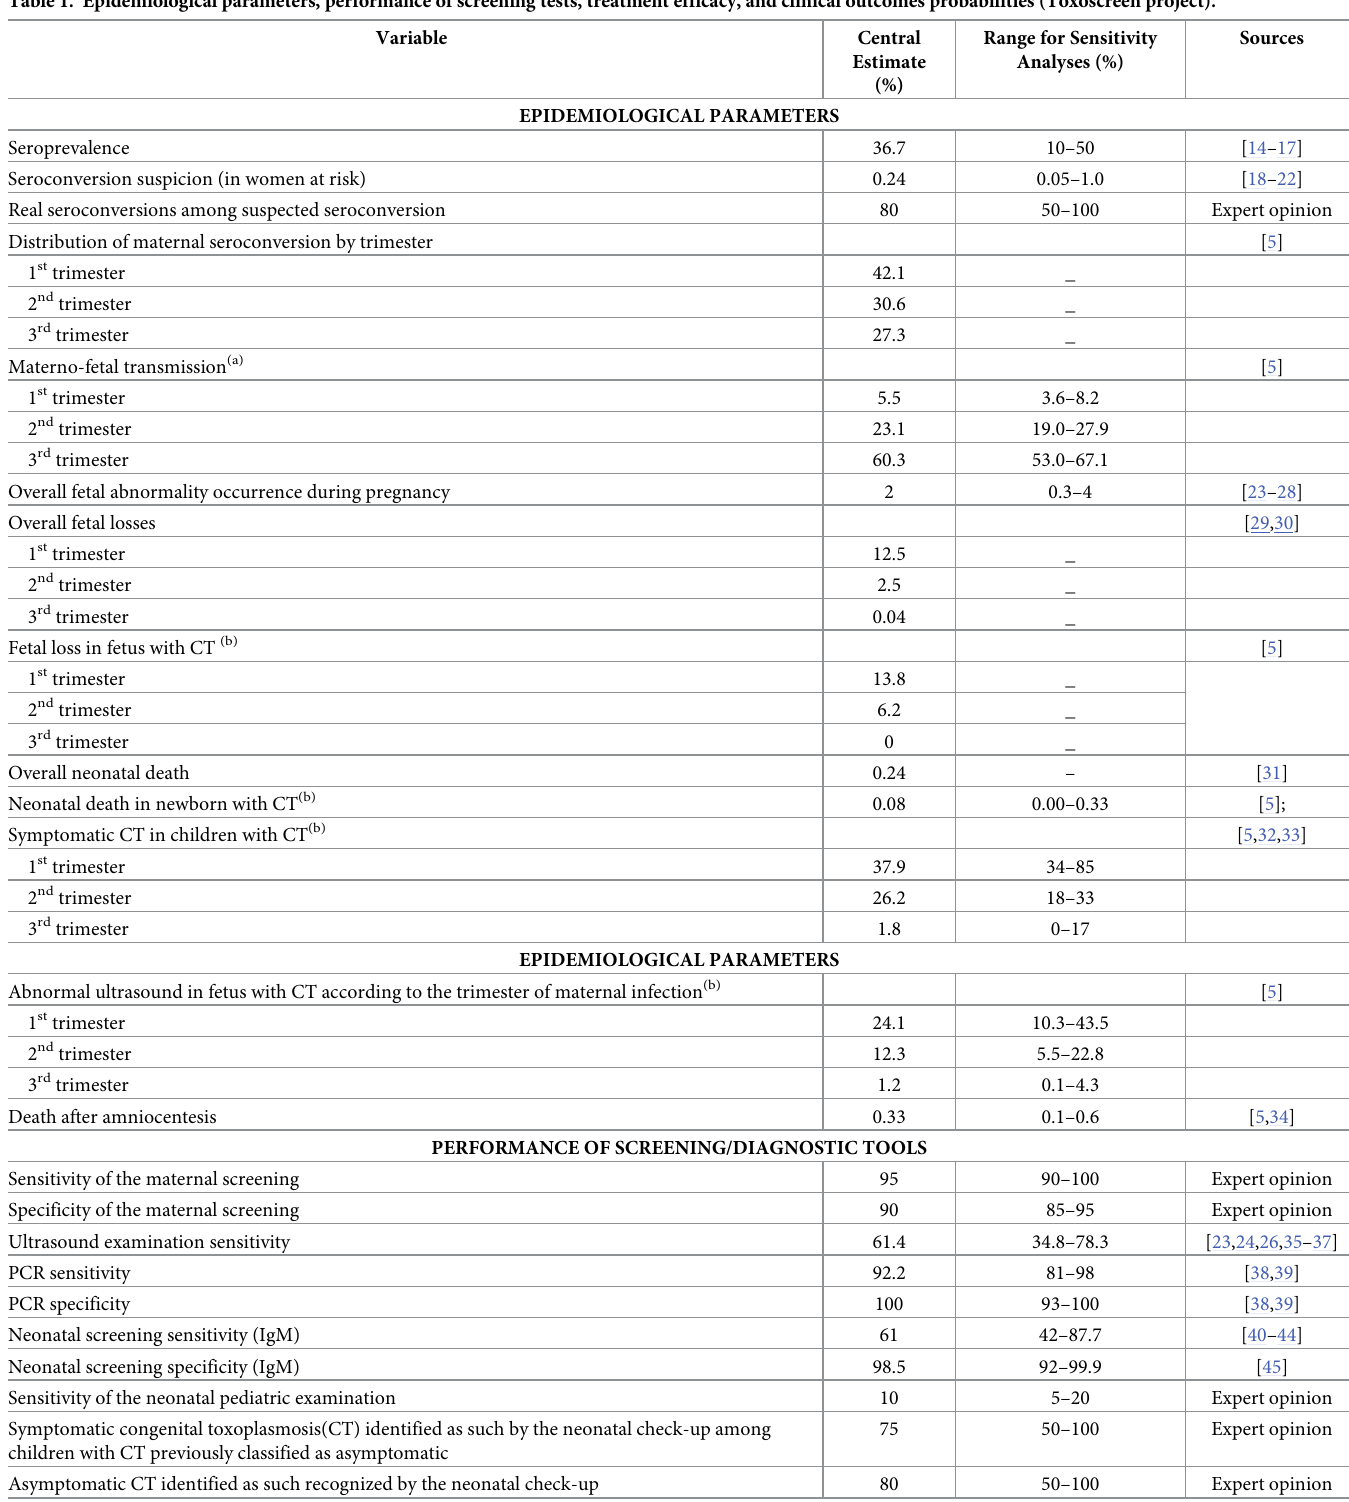
Table 1. Epidemiological parameters, performance of screening tests, treatment efficacy, and clinical outcomes probabilities (Toxoscreen